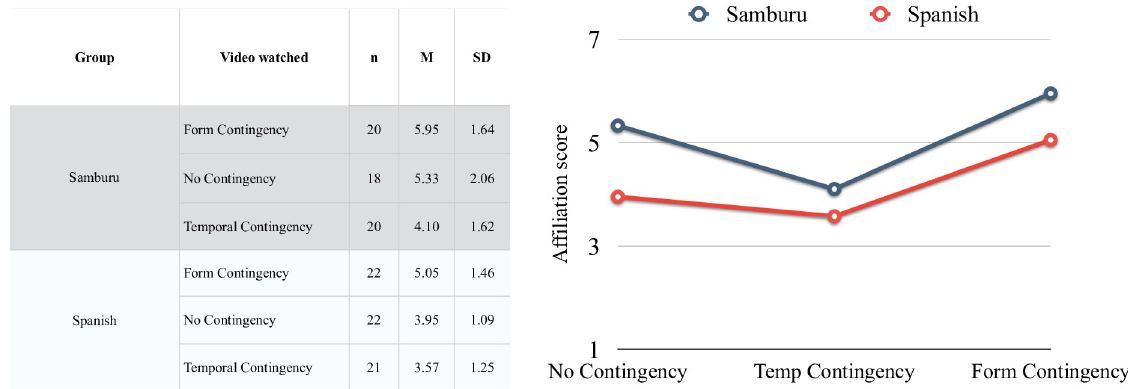
Fig 2. Means and standard deviations of the perceived affiliative status attributed to the actors as a function of the participant’s group and the video watched.